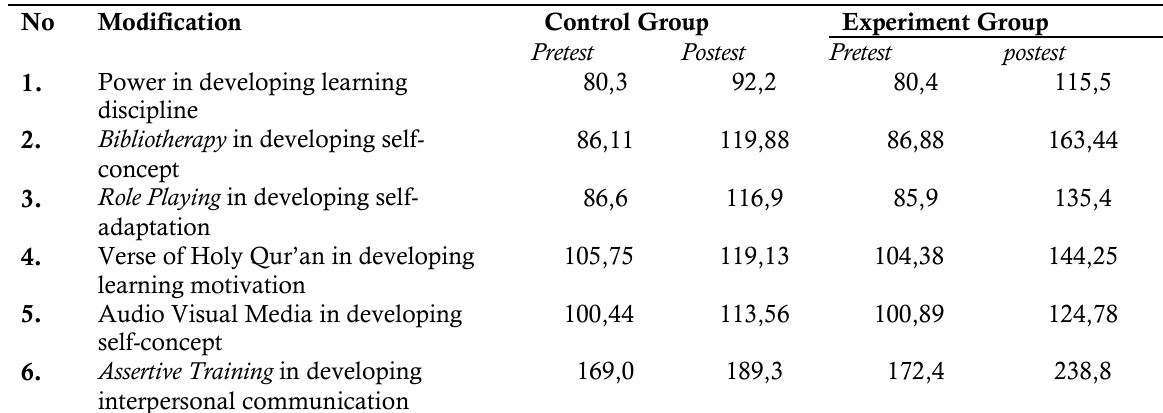
Table 1. Comparison between Pretest and Posttest with the use of Non Equivalent